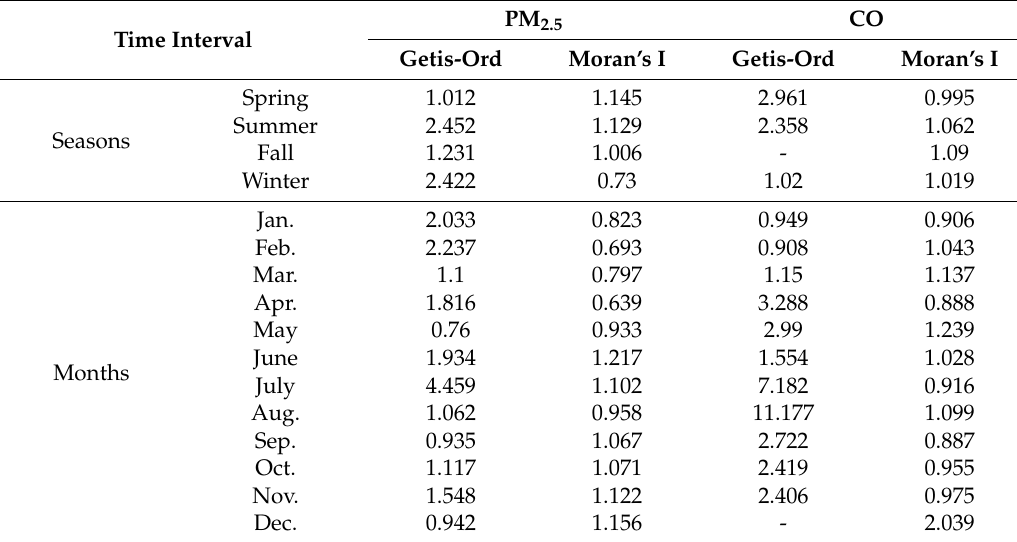
Table 3. Developed pollution cleanliness index (PCI)